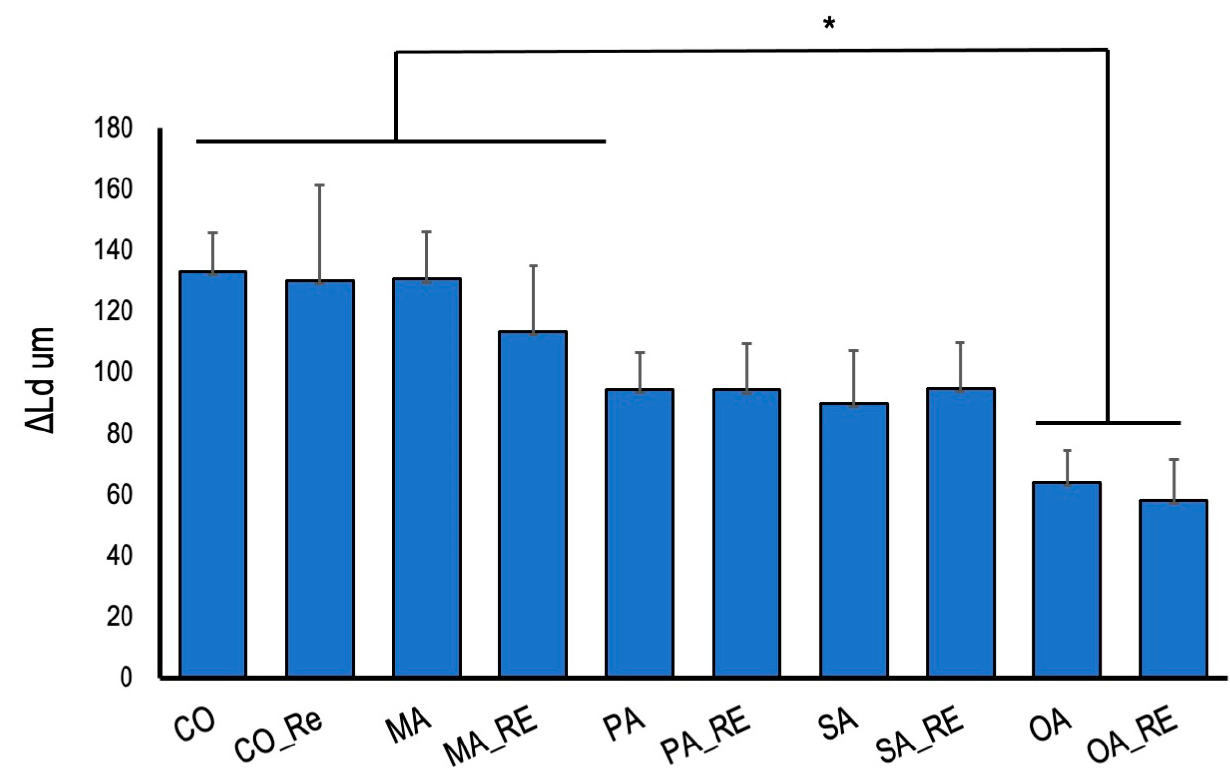
Figure 9. Lesion depth differences ( ∆ Ld) after 2 weeks of cariogenic pH cycling. Asterisk significant differences (one-way ANOVA and Tukey’s tests, p < 0.05).